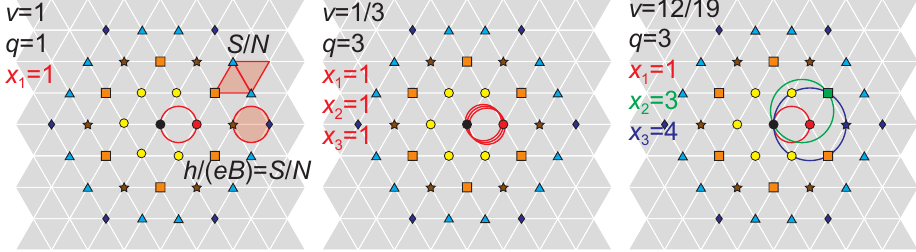
Figure 6. Illustration of some selected homotopy patterns protected by invariants